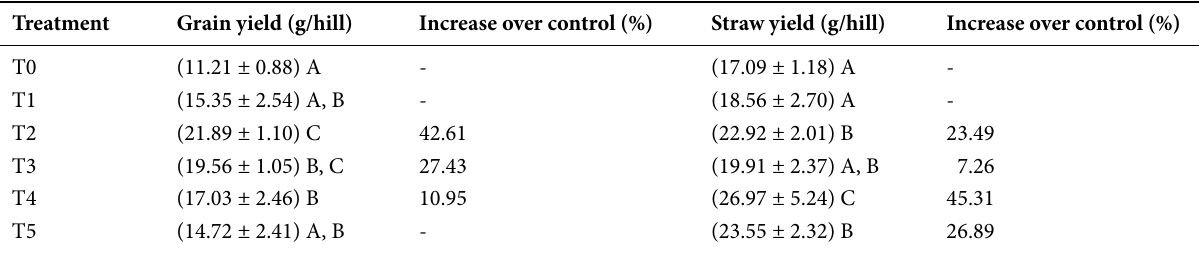
Table 2 Grain and straw yields of the rice ‘Swarna’ influenced by different treatments of B under saline conditions. Treatment Grain yield (g/hill) Increase over control (%) Straw yield (g/hill) Increase over control (%)